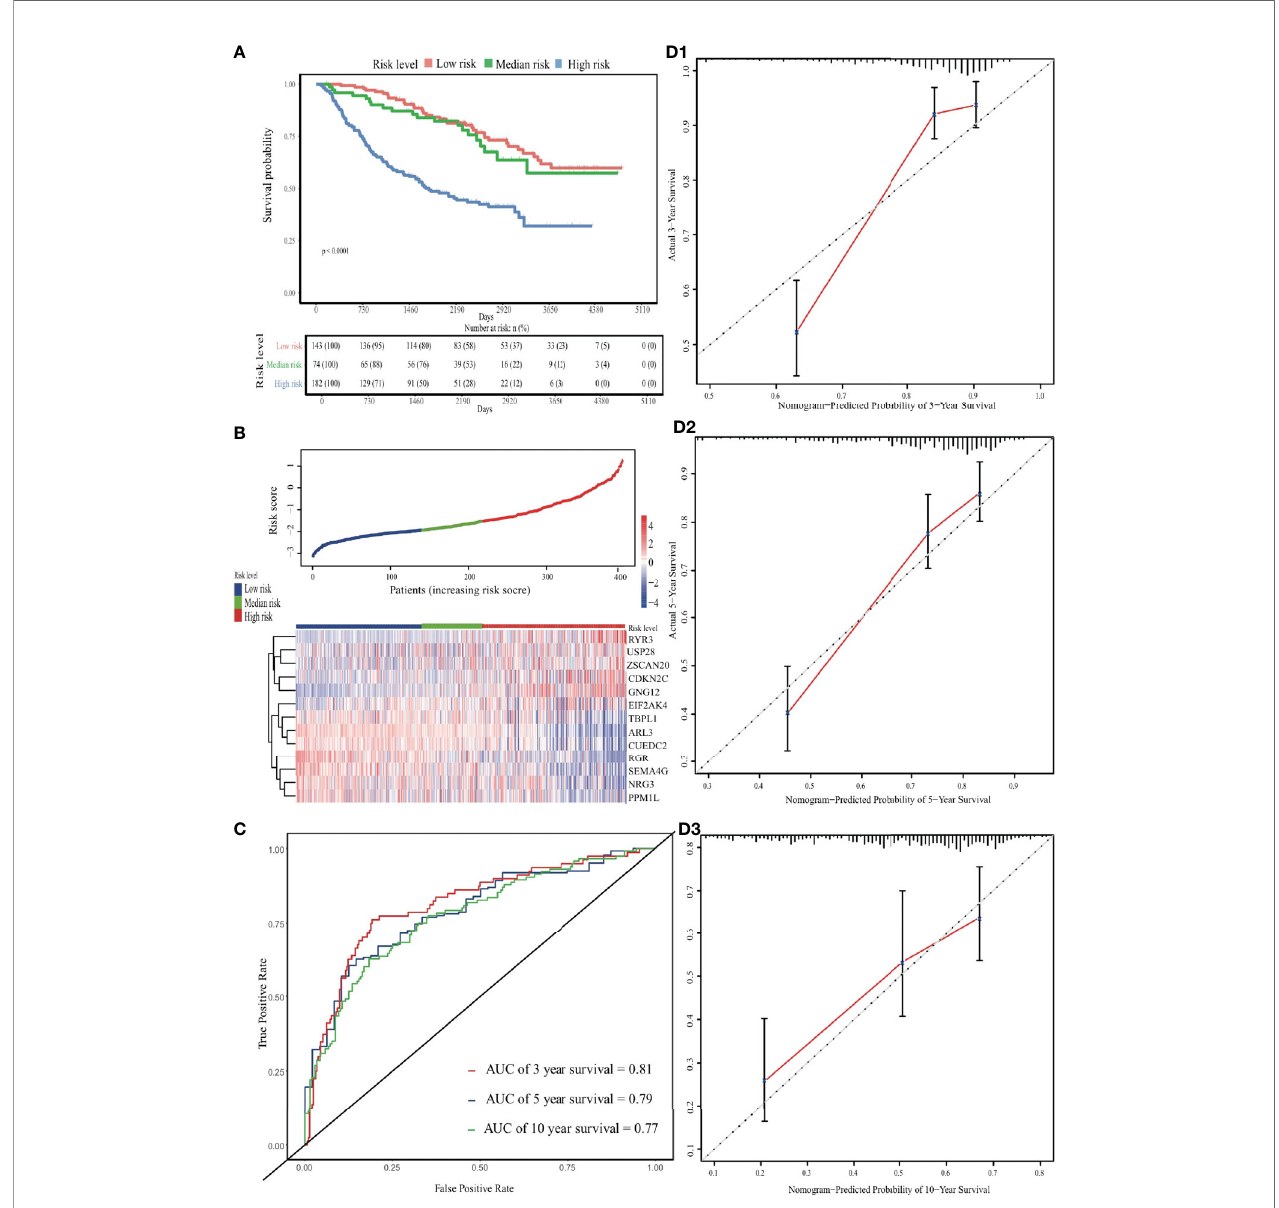
FIGURE 4 | Validation of the EDGs nomogram. (A) The Kaplan-Meier analysis of the risk scores. (B) The heatmap and distribution of EDGs expression pro fi le among three subgroups in CGGA cohort. (C) Time-dependent ROC curves for 3-, 5- and 10-year OS prediction. (D) The calibration curves for the OS nomogram in the CGGA cohort. The black diagonal lines represent the ideal performance in predicting OS, and the red lines represent the actual